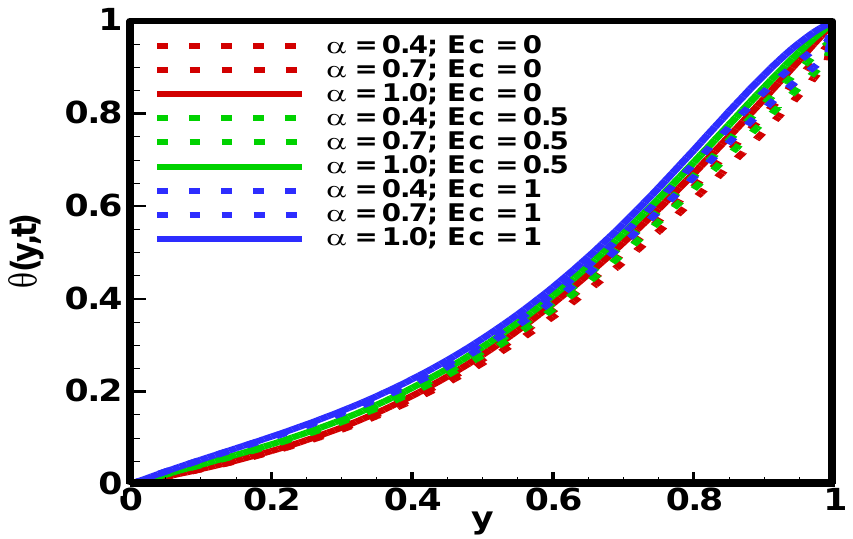
= 0.1, Pr = 21, Q s = 5, (cid:101) = 0.5 2